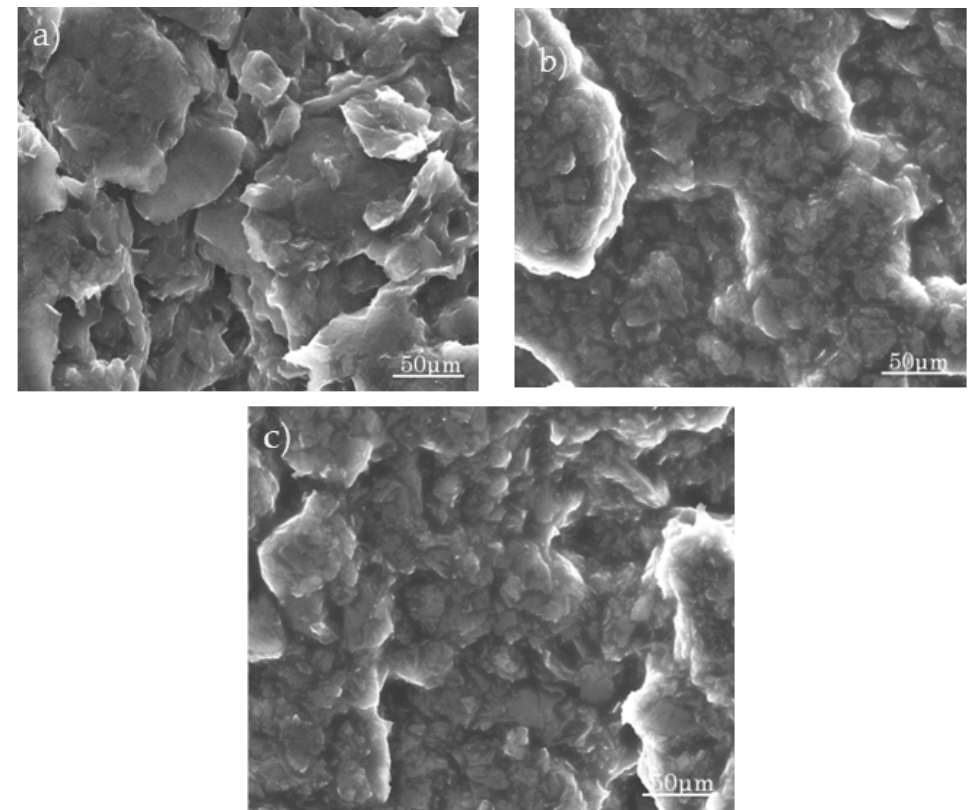
Figure 1. Representative SEM micrographs of: AuNPsnGr ( a ), PIX/AuNPsnGr ( b ), and PIXCoCl/AuNPsnGr ( c ).